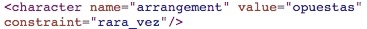
Structured text that exemplifies the use of adverbs in the chunk T112L4S2.